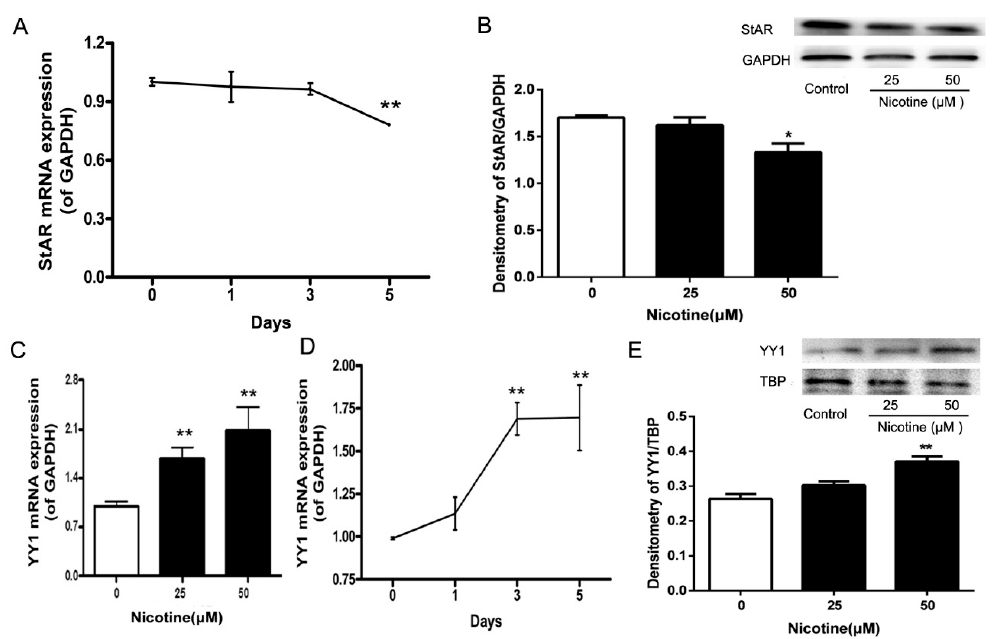
Figure 3. Time- and concentration-dependent effects of nicotine treatment on the expression of steroidogenic acute regulatory protein (StAR) and Yin Yang 1 (YY1) promoters in NCI-H295A cells. ( A ) qRT-PCR analysis for StAR mRNA expression (in a time-dependent manner); ( B ) Western blotting analysis for StAR protein expression; ( C ) qRT-PCR for YY1 mRNA expression (in a concentration-dependent manner); ( D ) qRT-PCR analysis for YY1 mRNA expression (in a time-dependent manner); ( E ) Western blotting analysis for YY1 protein expression. GAPDH: glyceraldehyde-phosphate dehydrogenase; TBP: TATA-binding protein. Data are presented as the mean ± SEM, n = 5. * p < 0.05, ** p < 0.01 vs. control.